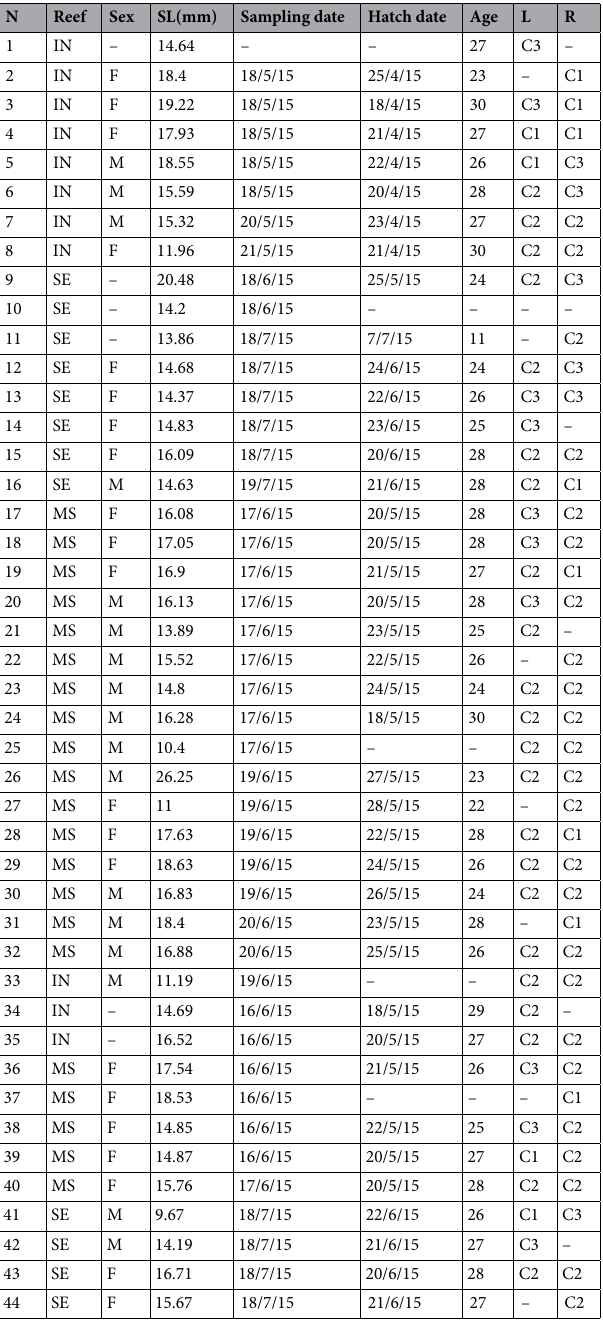
Table 2. Otolith data from female (F) and male (M) adult specimens (standard length “SL” in mm) of LDF Schindleria from the Red Sea, collected from May to July 2015 at three reefs along a cross-shelf gradient (one inshore “IN”, one at the mid-shelf “MS”, and one at the shelf-edge “SE”) near the coast of Thuwal, Saudi Arabia. The last columns “L” and “R” indicate the quality assigned (C1-C3) to each, left and right sagittal otolith, respectively, where C1 represents poor/unreadable conditions, C2 conditions sufficiently good for readings, and C3 ideal